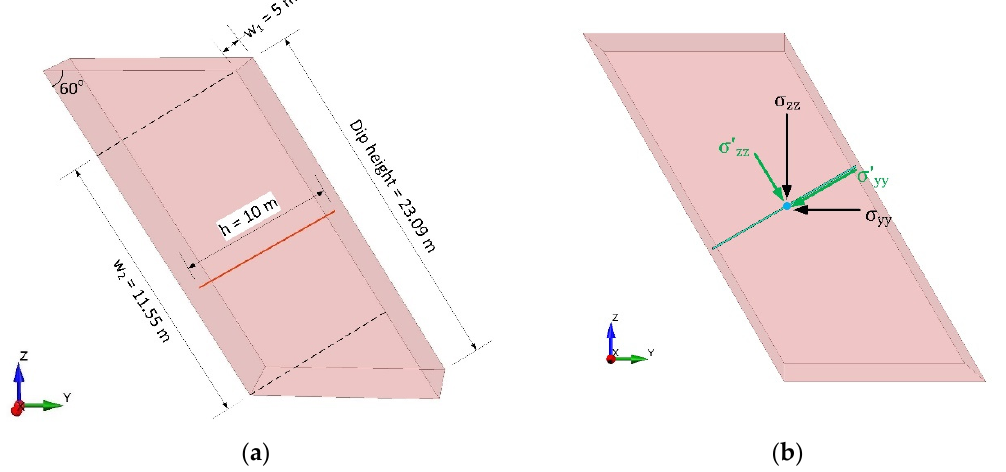
Figure 3. ( a ) Rib pillar geometrical dimensions. ( b ) Stress transformation along the line query.